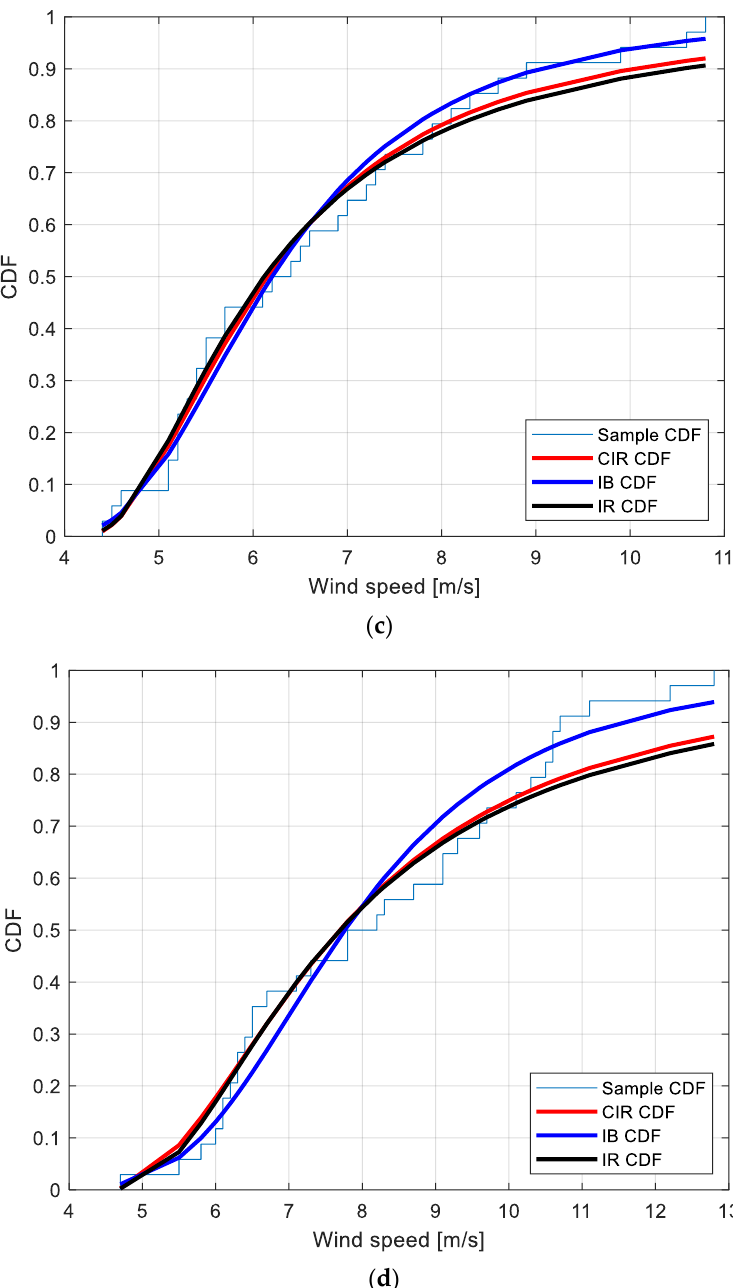
Figure 3. Sample CDF and fitted CIR, IB and IR distributions for the PM EWS at the locations: ( a ):